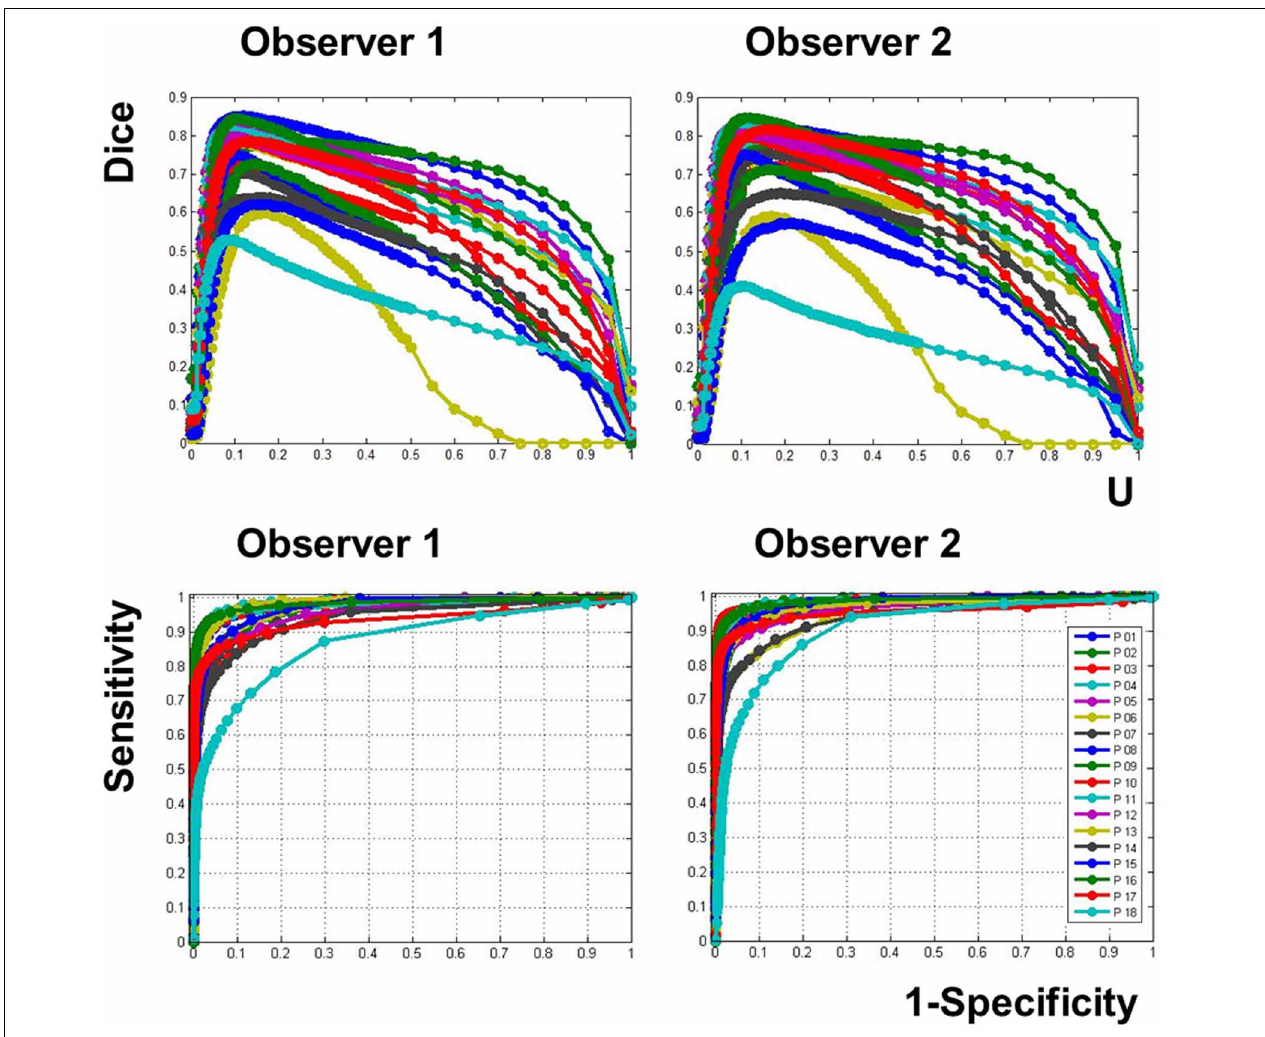
FIGURE 4 | (Top Panel) Dice’s similarity index when the binary lesion from the recursive ALI procedure is compared to each observer’s manual segmentation (left = Observer 1; right = Observer 2), across a range of different U thresholds used to convert the fuzzy image into a binary image.